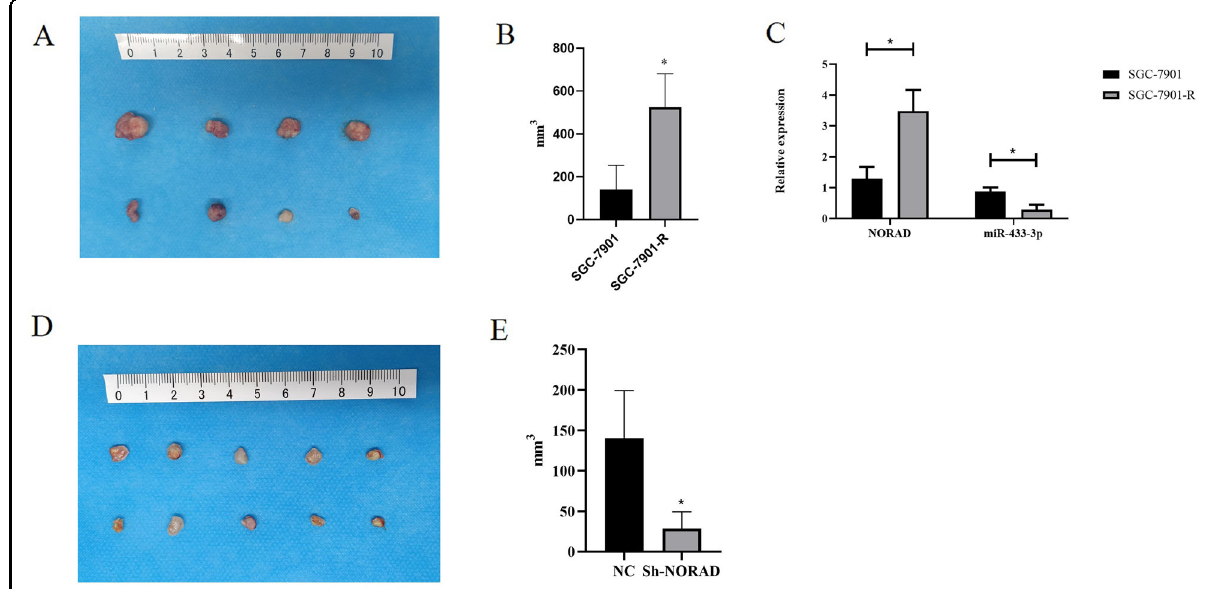
Fig. 8 NORAD regulated oxaliplatin resistance in vivo. A Xenograft tumors from 10 nude mice ’ right fl ank. SGC-7901 and SGC-7901-R was used to produce the xenograft tumors. B Estimated volumes of xenograft tumors: volume = π /6 × width 2 × length ( t = 4.383, P = 0.002). C NORAD ( t = 14.52, P = 0.001) and miR-433-3p ( t = 4.98, P = 0.031) expression in SGC-7901 and SGC-7901-R generated xenograft tumors. D Xenograft tumors from 10 nude mice ’ right fl ank. SGC-7901-R transduced with NORAD knockdown lentivirus and relevant NC cells were used to produce the xenograft tumors. E Estimated volumes of xenograft tumors: volume = π /6 × width 2 × length ( t = 5.489, P =